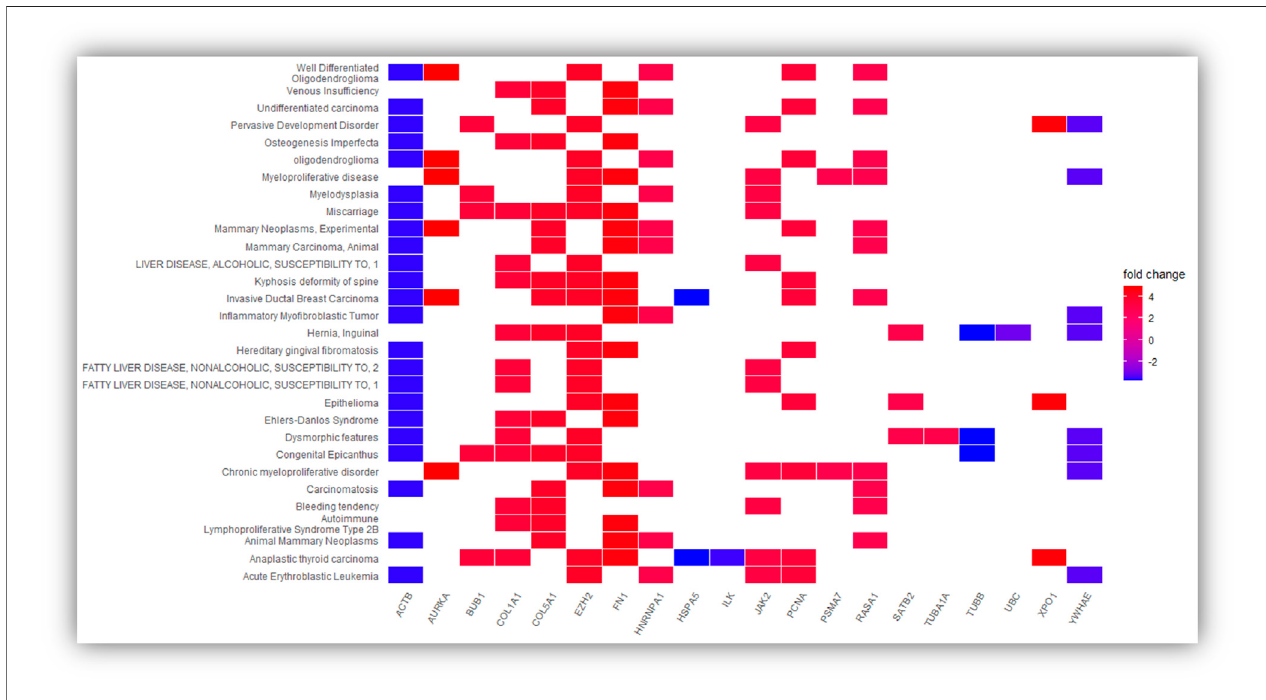
FIGURE 4 | Represent the signi fi cantly over-expressed and under expressed genes present in the DisGeNET disease and genes involved in the signi fi cantly enriched DisGeNET disease. The depth of the color represents the fold change and the names of DisGeNET disease displayed vertically.